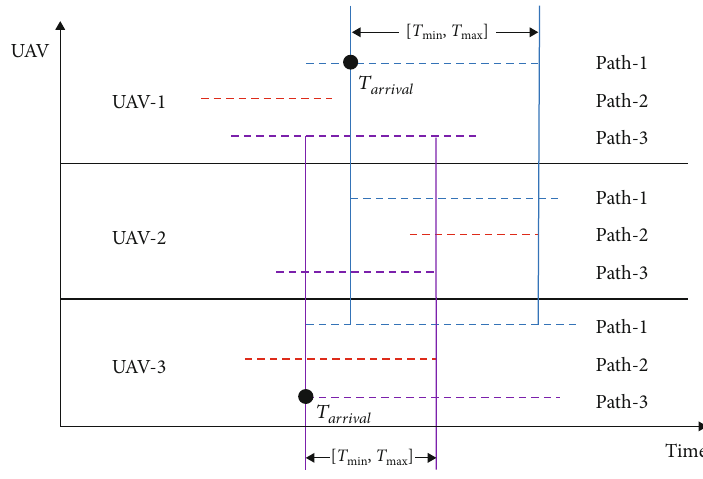
Figure 8: Time collaboration